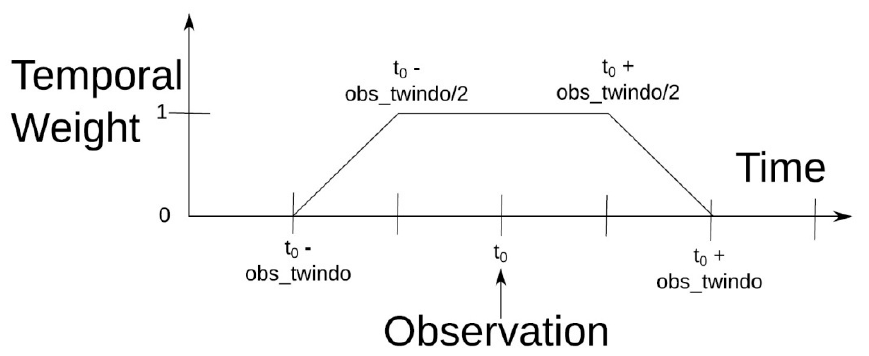
Figure A1. Temporal weighting function for an observation at time t 0 based on the WRF namelist setting obs_twindo.